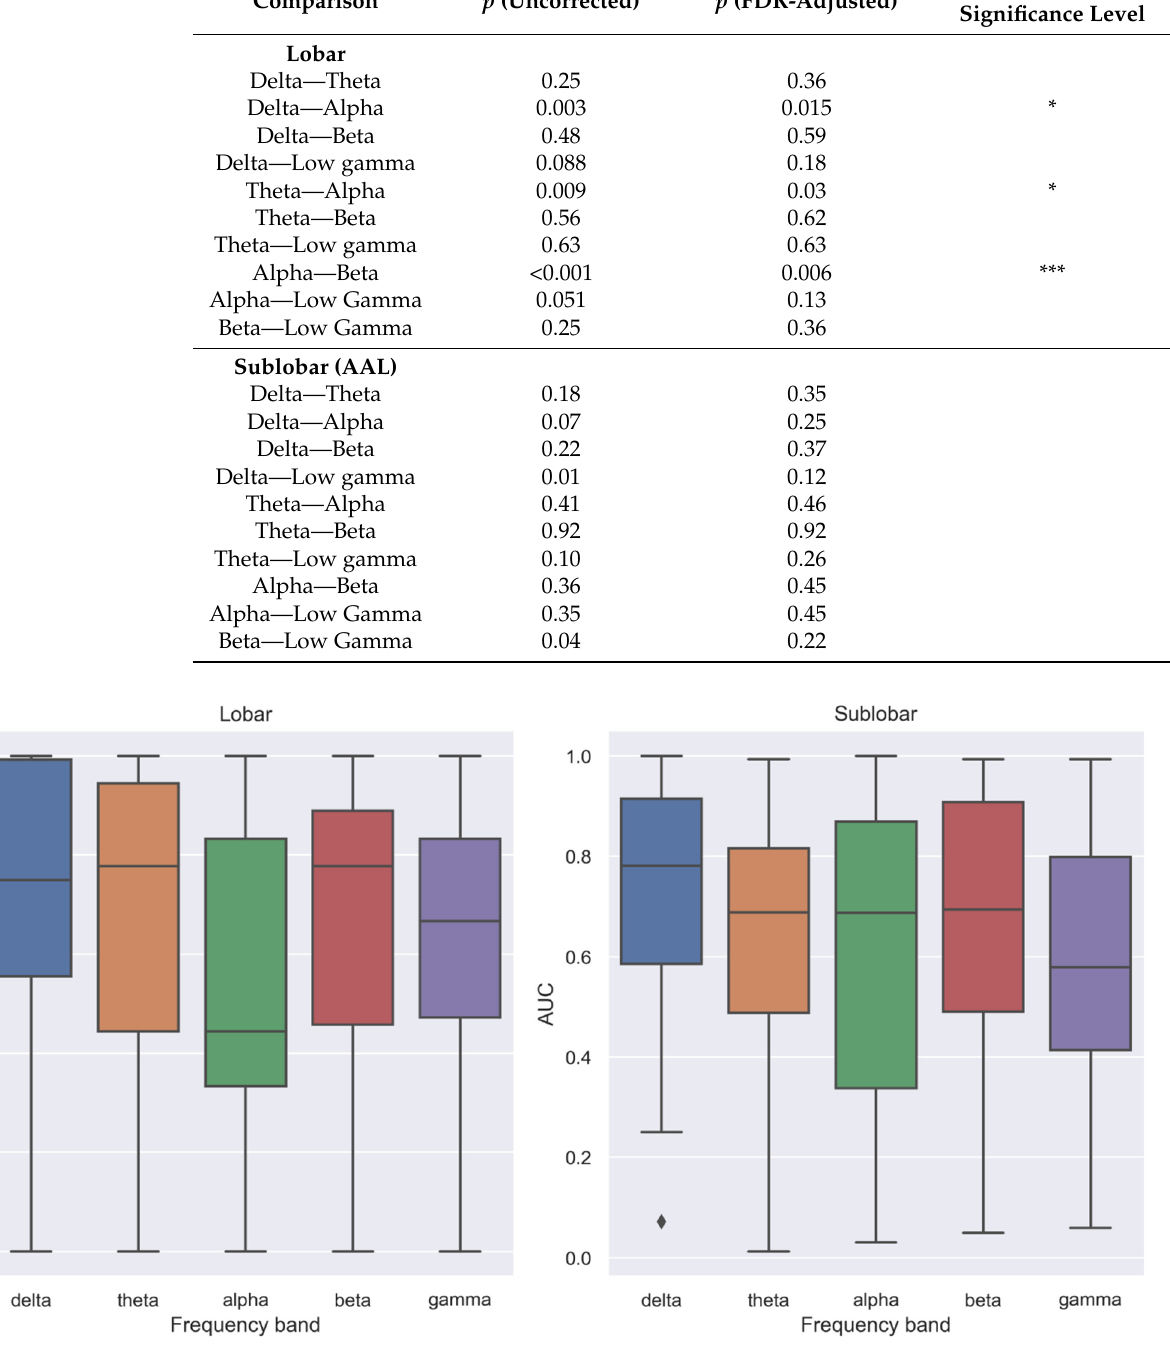
Table 2. Ratio of node degree values inside vs. outside the iEEG SOZ. Significance levels: * p < 0.05, ** p < 0.01, *** p < 0.001.